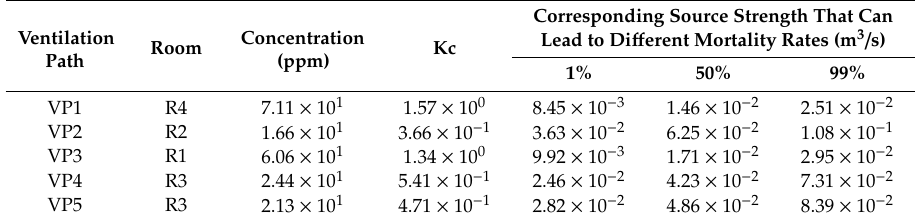
Table 3. The corresponding source strength calculated by the lowest concentration room when the pollutant source is leaked at y = 0 W.